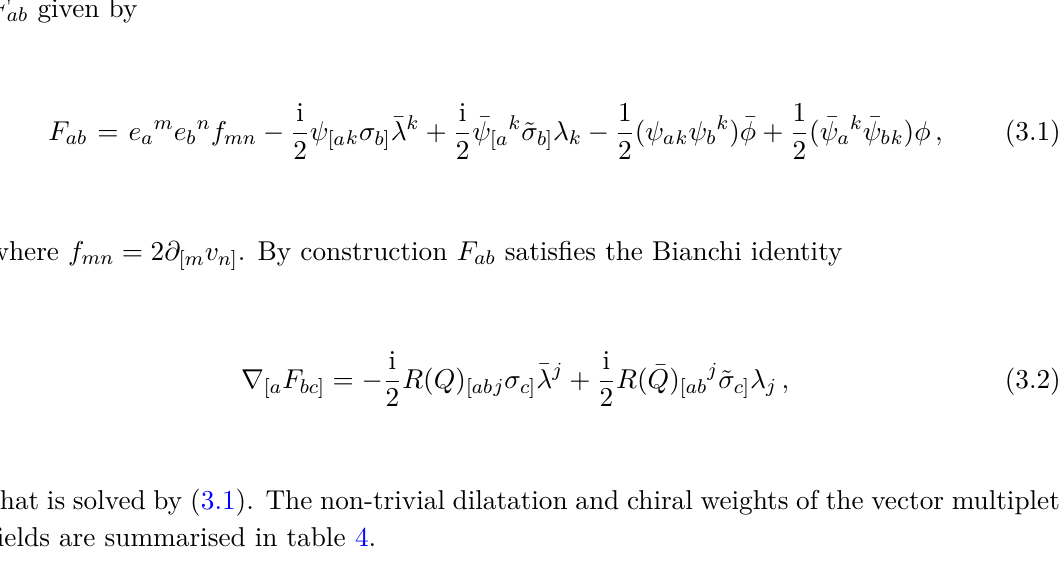
and a real Abelian gauge connection v F given ab